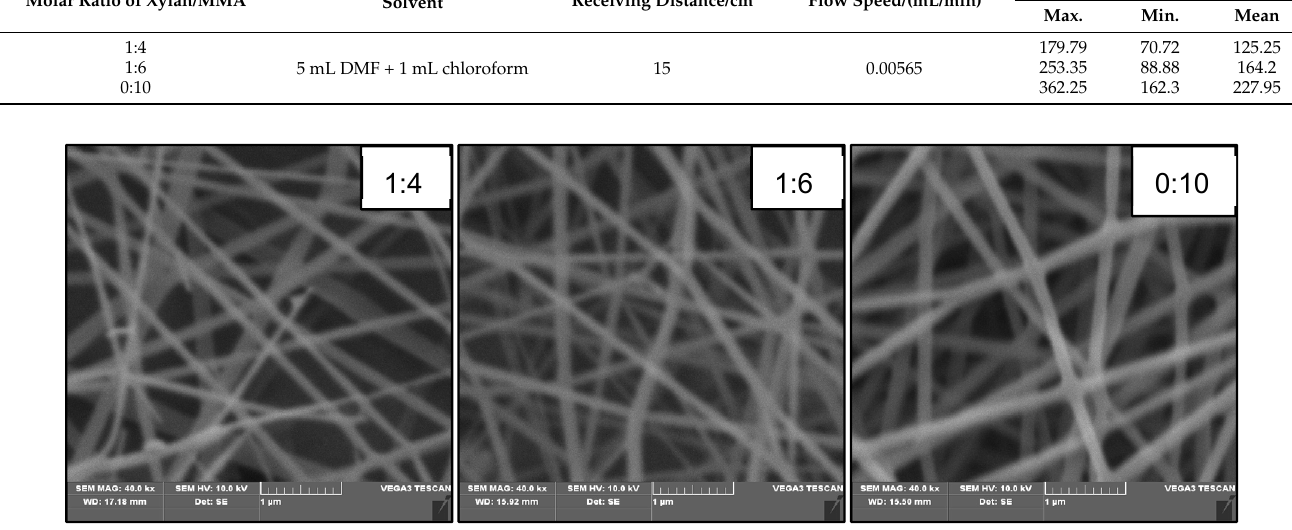
Figure 5. The SEM images (40 kx) of the electrospun fibers were produced with AXU/MMA molar ratios of 1:4, 1:6, and 0:10.